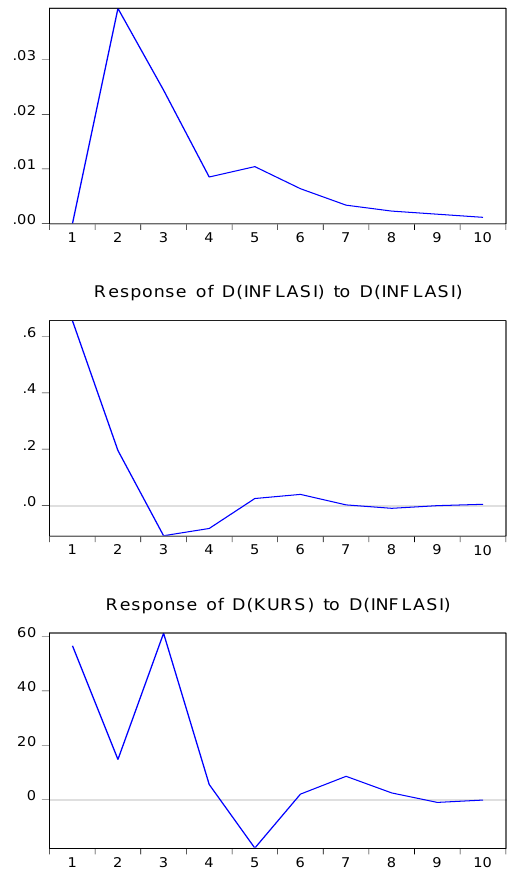
Figure 2: The inflation